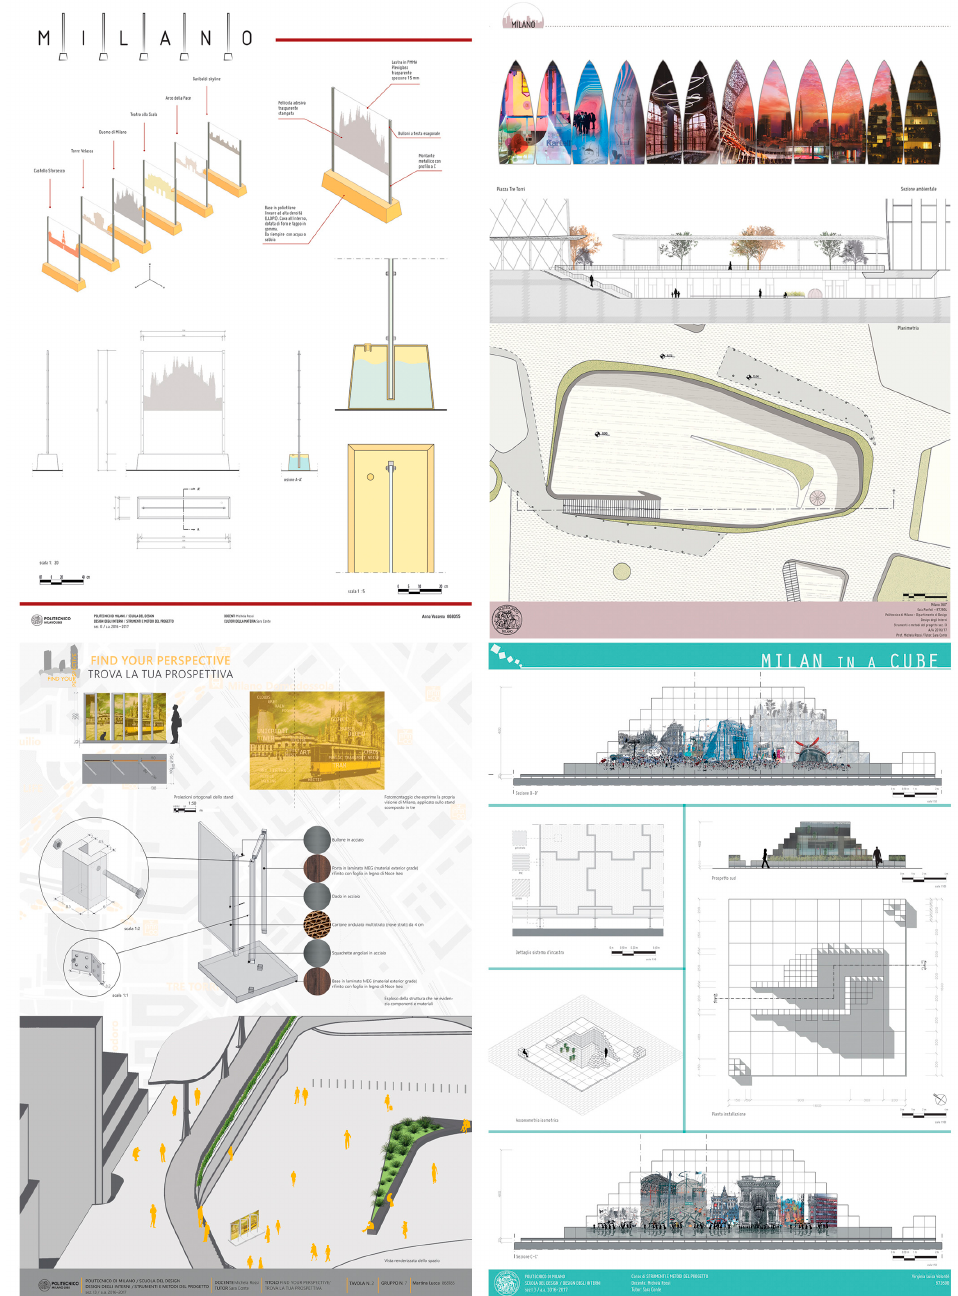
Figure 5. Some art boards of final project. In the first one, the construction process of the collage determinates the design of the